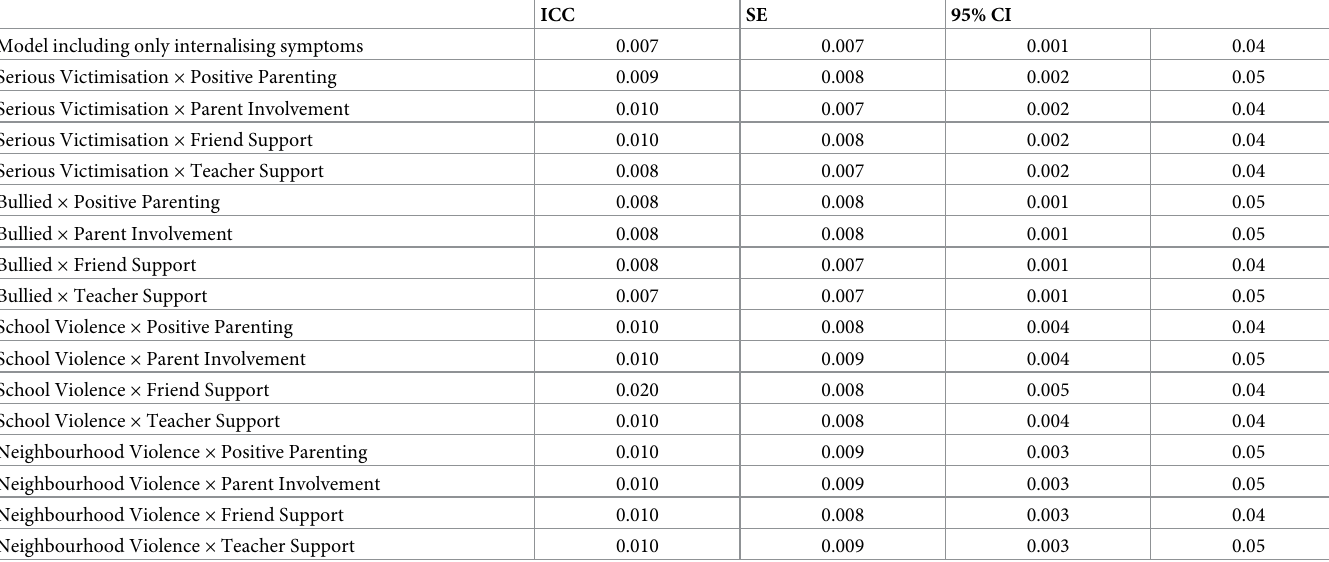
Table 2. Intraclass correlation coefficient of model with internalising symptoms only and final models at the school level